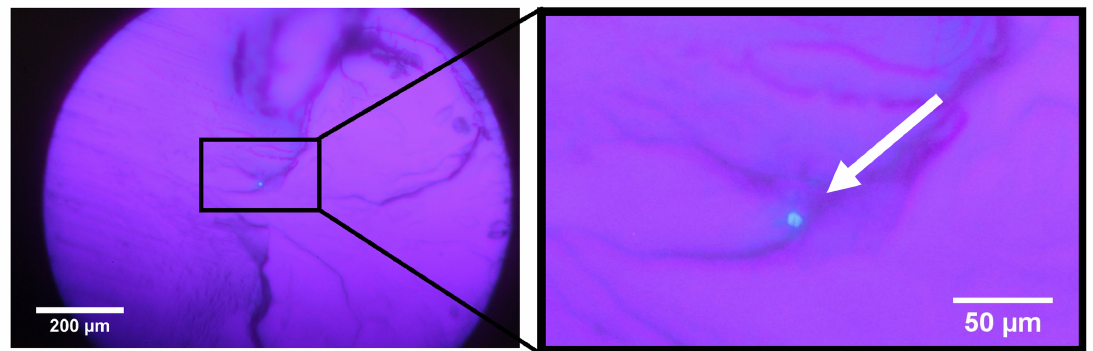
Figure 8. Unpolished Endface of active few-mode fiber under UV illumination at 365nm. The fiber core (marked with arrow) is doped with 3-vinylayapin 2 . The core diameter is 8.8